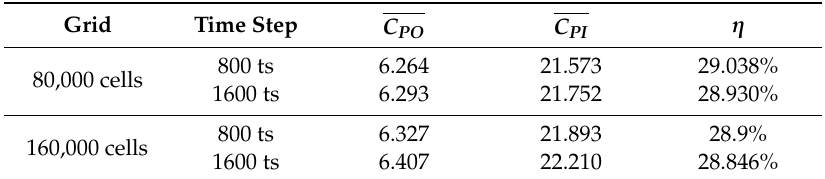
Table 1. Grid and time independence.